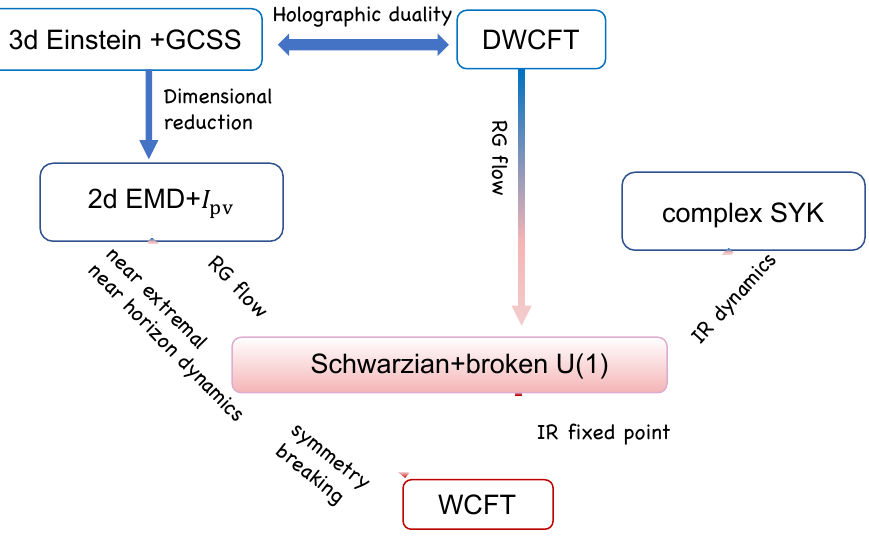
Figure 1 . This diagram summarizes the web of relations we have identified between 3D and 2D theories of gravity with specific boundary conditions, and their holographic duals. In particular, these relations connect AdS 3 gravity with generalized CSS boundary conditions, warped CFTs, 2D Einstein-Maxwell-dilaton gravities, and complex SYK